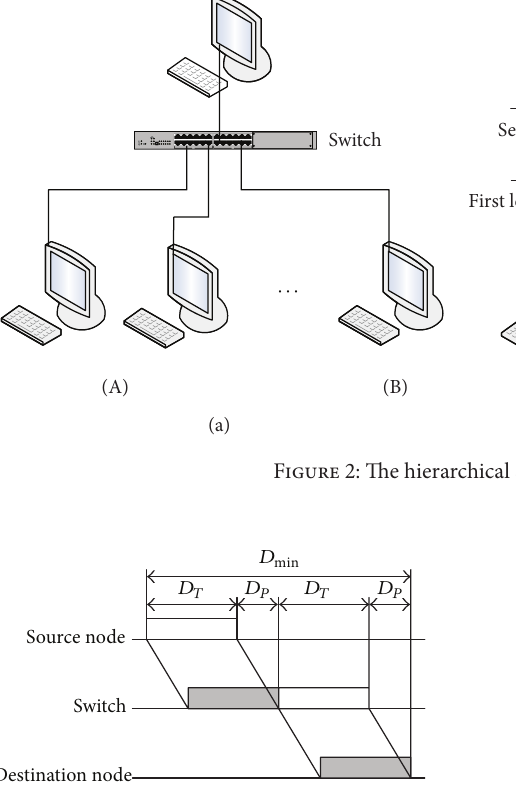
Figure3:Thetimingdiagramoftheminimumdelayofasingle-level switched Ethernet.